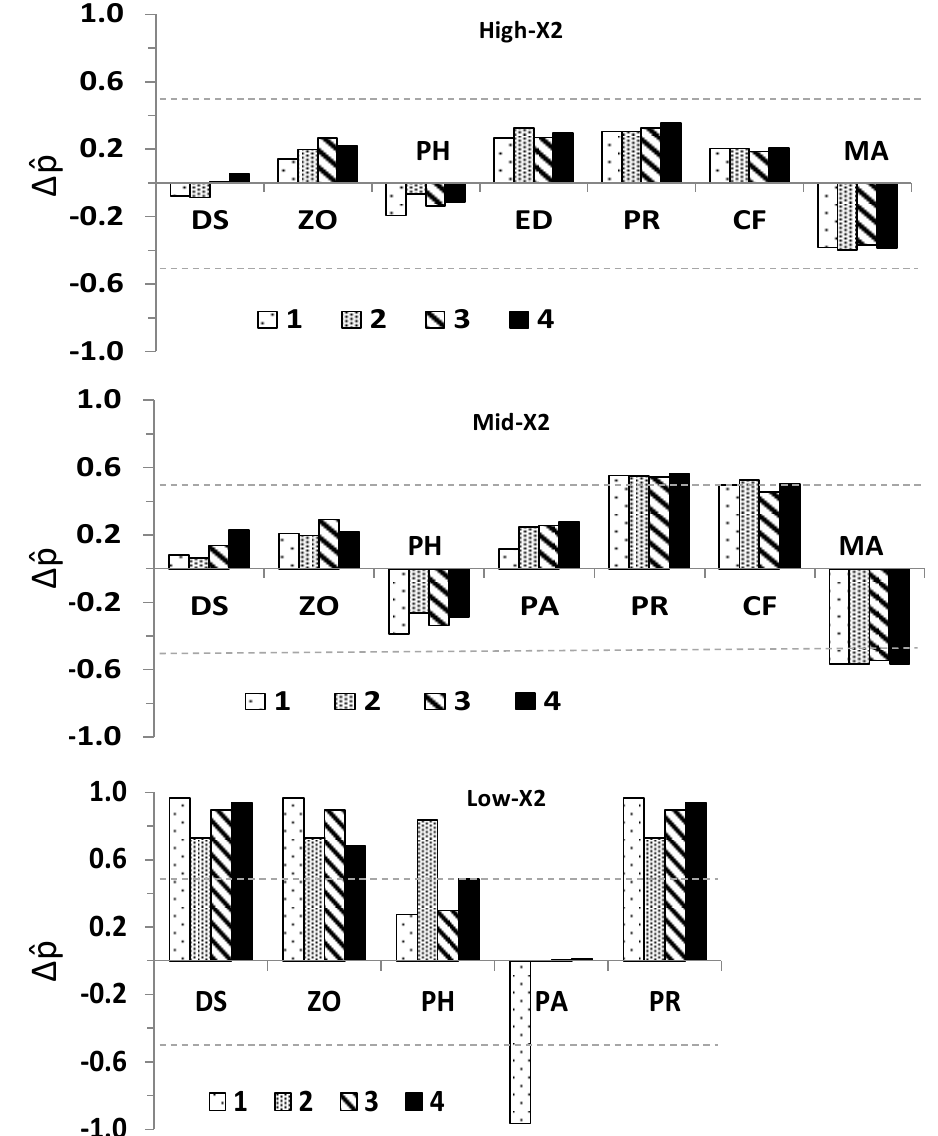
Figure 6. Predicted direction of change of community variables for low-, mid-, and high-X2 positions based on the difference between the proportions of quantitative simulations with positive and negative Adj − A (Δ p̂ ). Acronyms represent species or trophic groups (Table 1, Figure 3) and legend denotes the four outflow input scenarios (Figure 4). Values of │ Δ p̂ │ can range between 1 (unconditional sign determinacy) and 0 (complete uncertainty), with │ Δ p̂ │ between 0.5 (dotted lines) and <1 implying low uncertainty in the predicted direction of change.